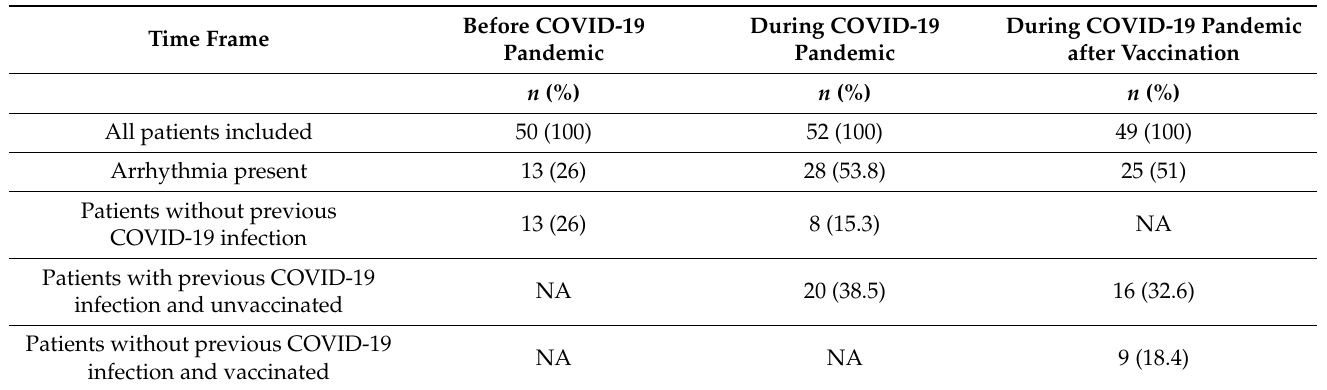
Table 1. Patients with presence of arrhythmia in different time frames.